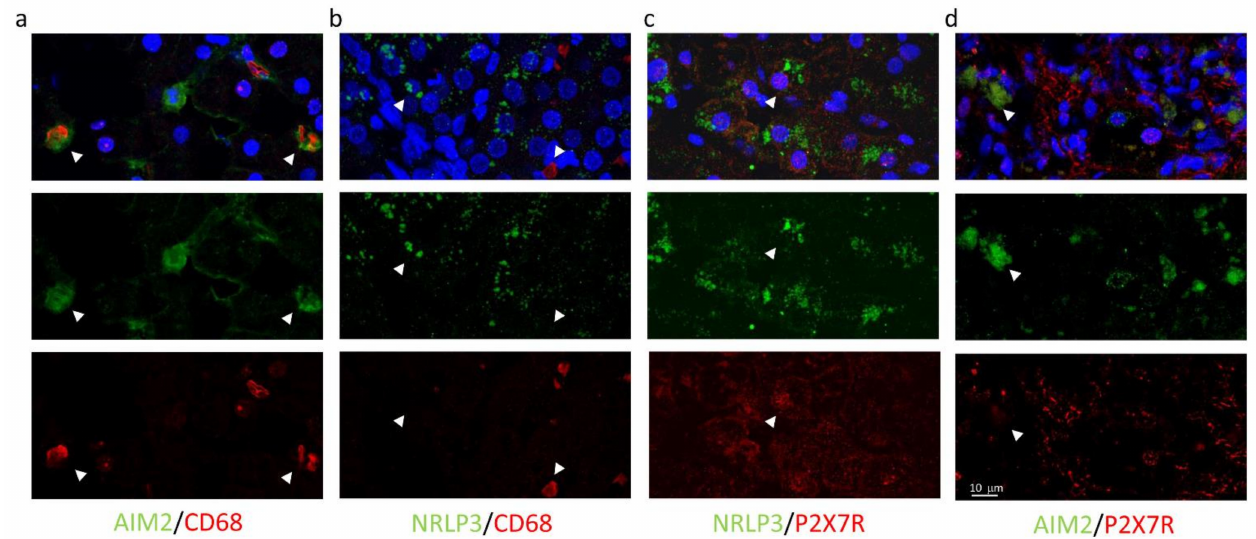
Figure 6. Confocal images of liver biopsies treated with the combination of primary antibodies confirm the expression of AIM2 (but not NRLP3) in CD68 + cells ( a , b ); conversely, P2X7R colocalizes with NRLP3 inflammasome (but not with AIM2) ( c , d ). In the first line, multicolor images: merge of primary antibodies and DAPI nuclear staining. In the second and third line: green and red indicate primary antibodies. Magnification 40 × ,